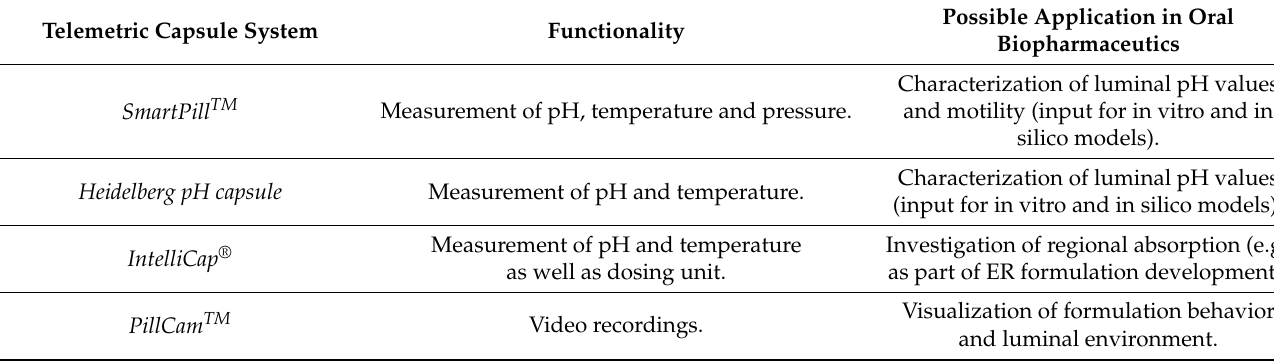
Table 6. Telemetric capsule